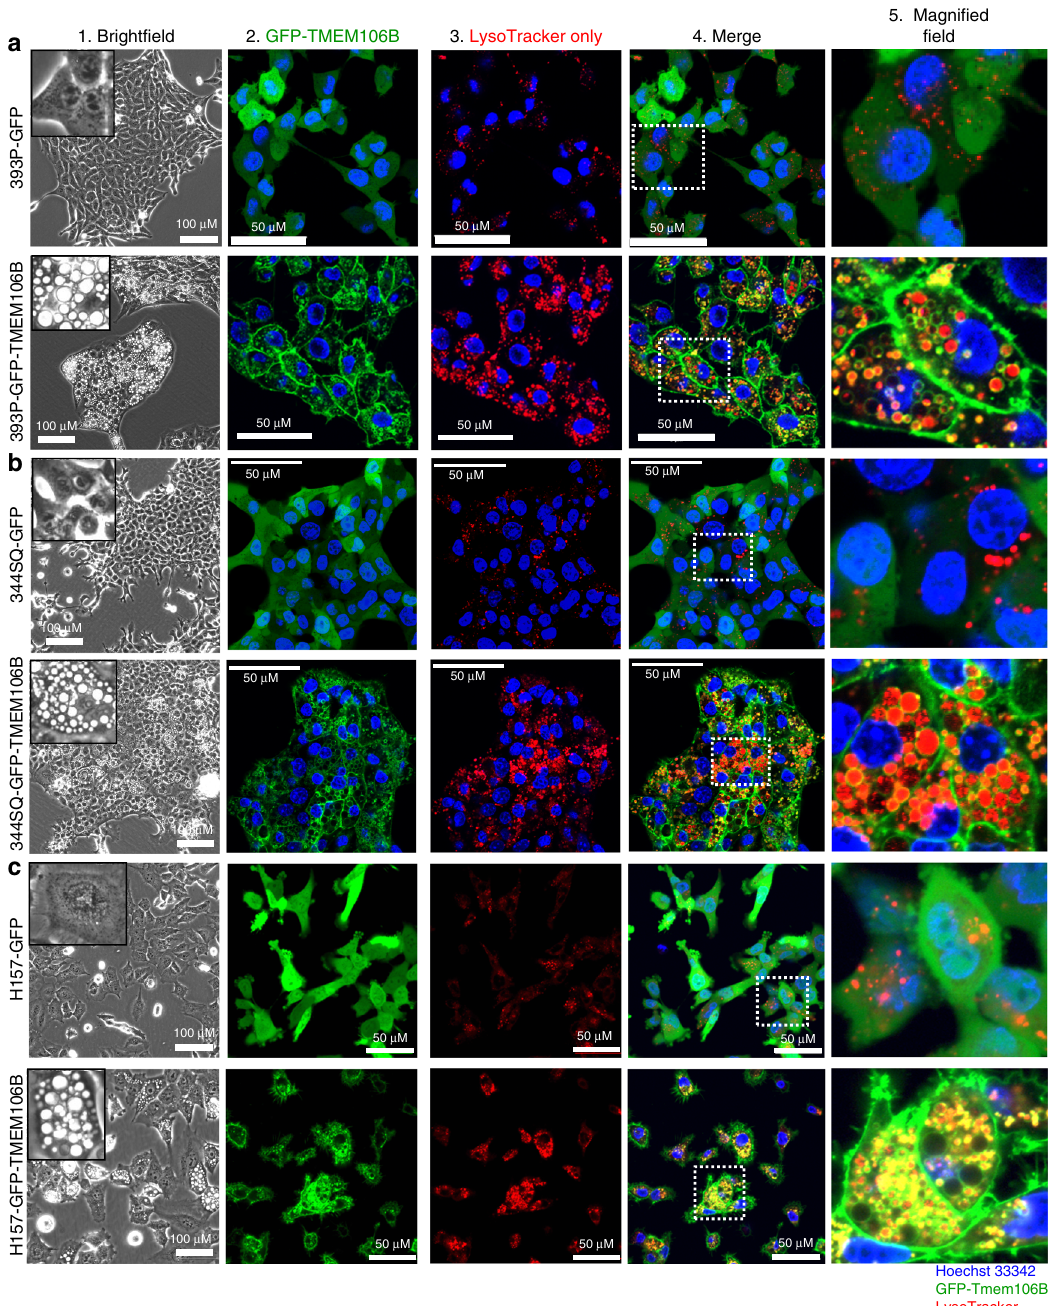
Fig. 3 TMEM106B induces synthesis of increased number and size of lysosomes. a – c Human or mouse lung cancer cells induced to express either GFP as control, or GFP-tagged TMEM106B were imaged as indicated. (1) Cells imaged in bright fi eld show enlarged vesicular structures formed upon expression of TMEM106B. (2 – 5) Cells were incubated with LysoTracker stain and counter stained with Hoechst33342, imaged live in real time as indicated. TMEM106B- expressing cells form enlarged lysosomes that stain positive for LysoTracker. Magni fi ed fi elds exhibit the stained